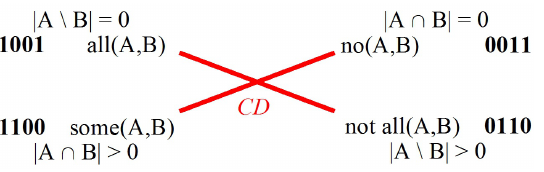
Figure 4. Degenerate square with bitstrings of length 4 for F all , relative to FOL